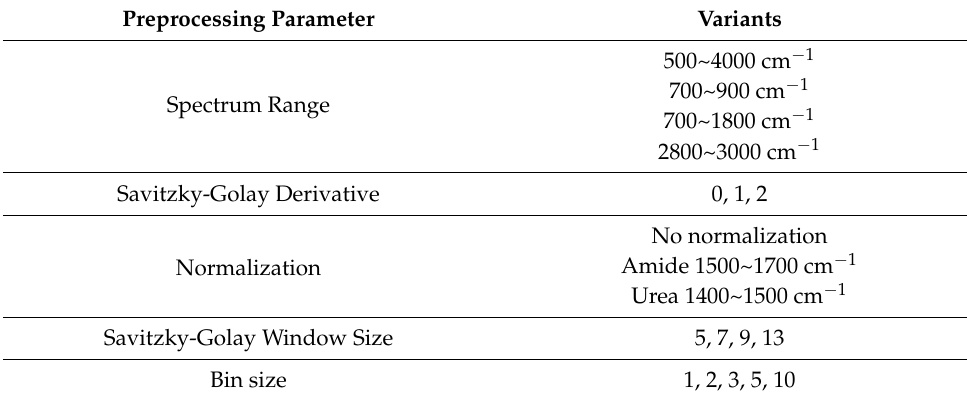
Table 2. Preprocessing parameters for spectra. Preprocessing Parameter